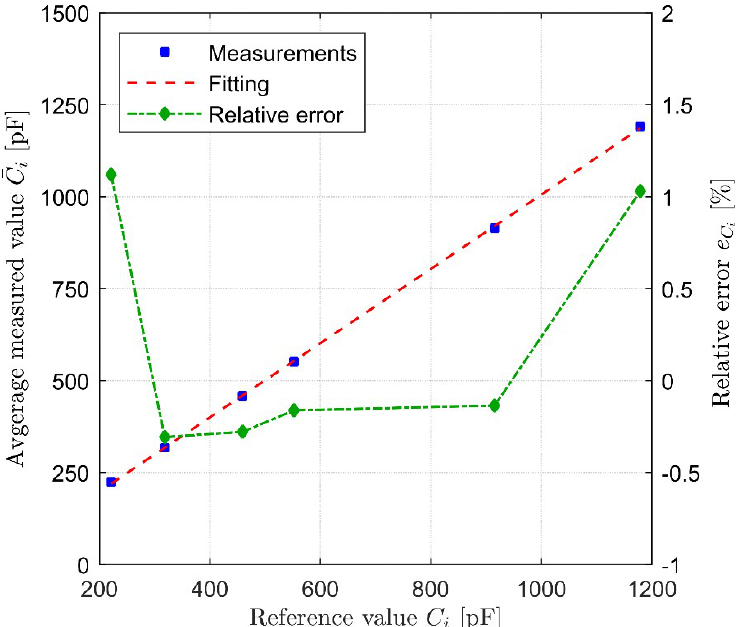
Figure 9. Average values C i calculated over 40 repeated measurement and relative errors e Ci versus the measured reference values C i of the capacitors.